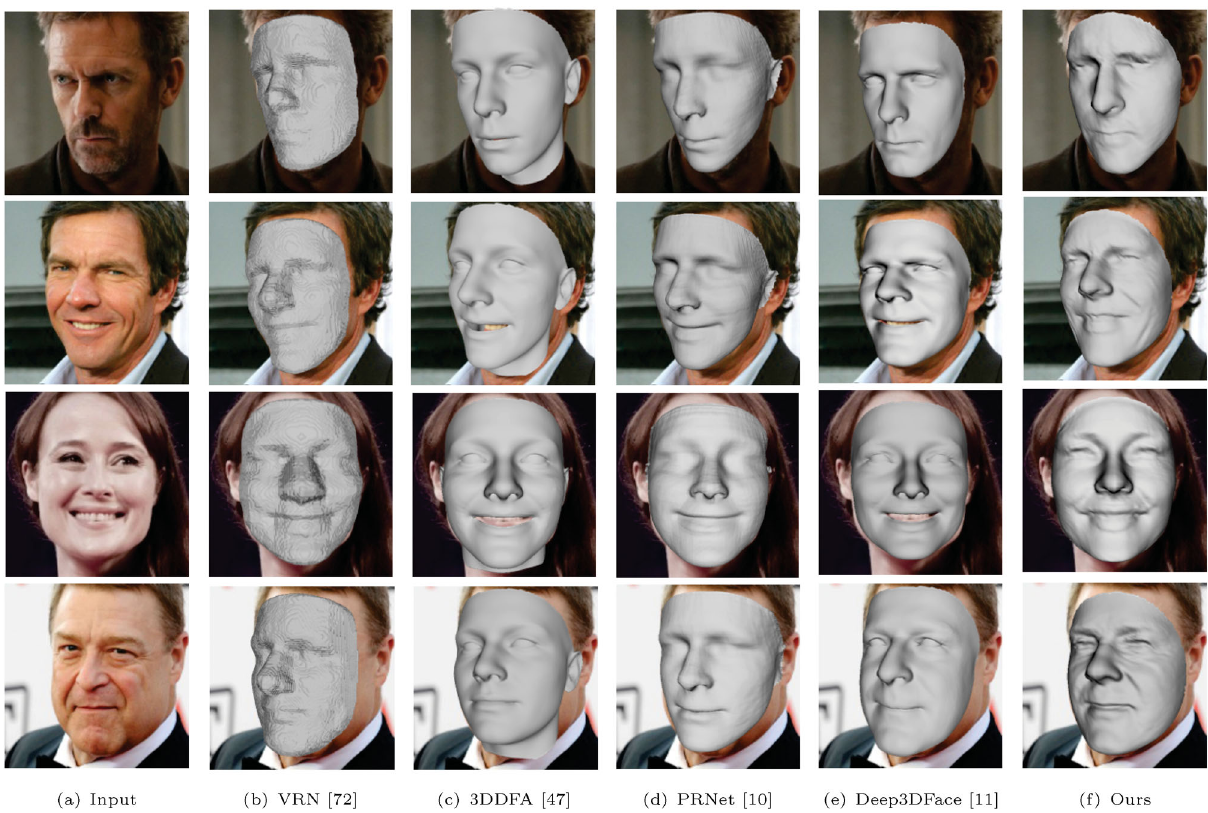
Fig. 9 Qualitative comparison on unconstrained images between our method and several state-of-the-art methods: VRN, 3DDFA, PRNet, and